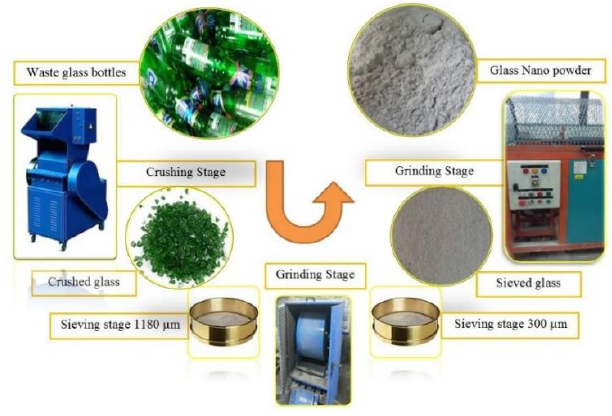
Figure 1. BGWNP preparation stages.